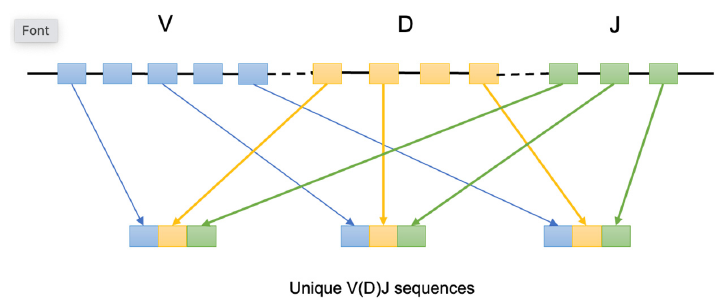
Figure 1. Schematic V(D)J rearrangement. The V(D)J rearrangement occurs during B ‐ cell develop ‐